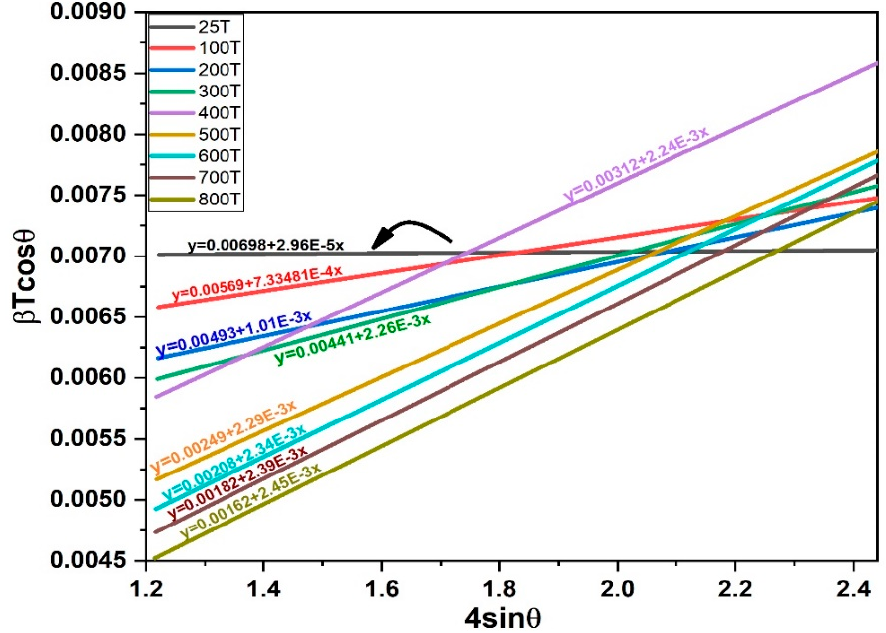
Figure 7. Williamson-Hall plot for 3C-SiC for different